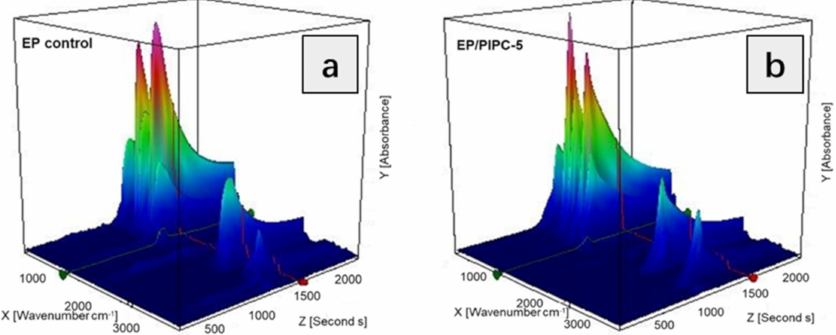
Figure 10. Infrared absorption 3D spectra of pyrolysis gas products of EP control ( a ) and EP / PIPC-5 ( b ). FTIR spectra of the pyrolysis products for the EP control and EP / PIPC-5 at di ff erent